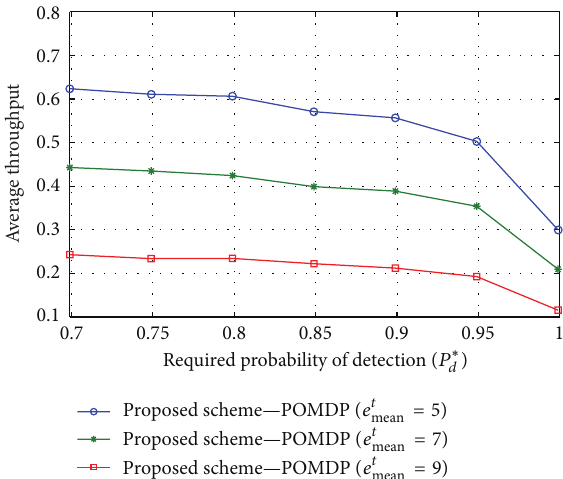
Figure 4: Average throughput versus the required detection proba- bility 𝑃 ∗ 𝑑 when 𝐸